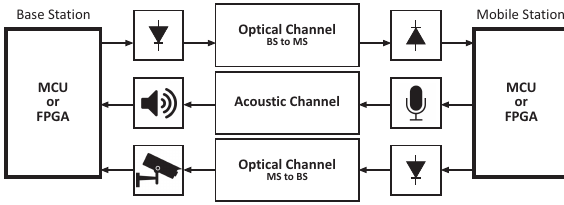
Figure 2. Block diagram of the proposed